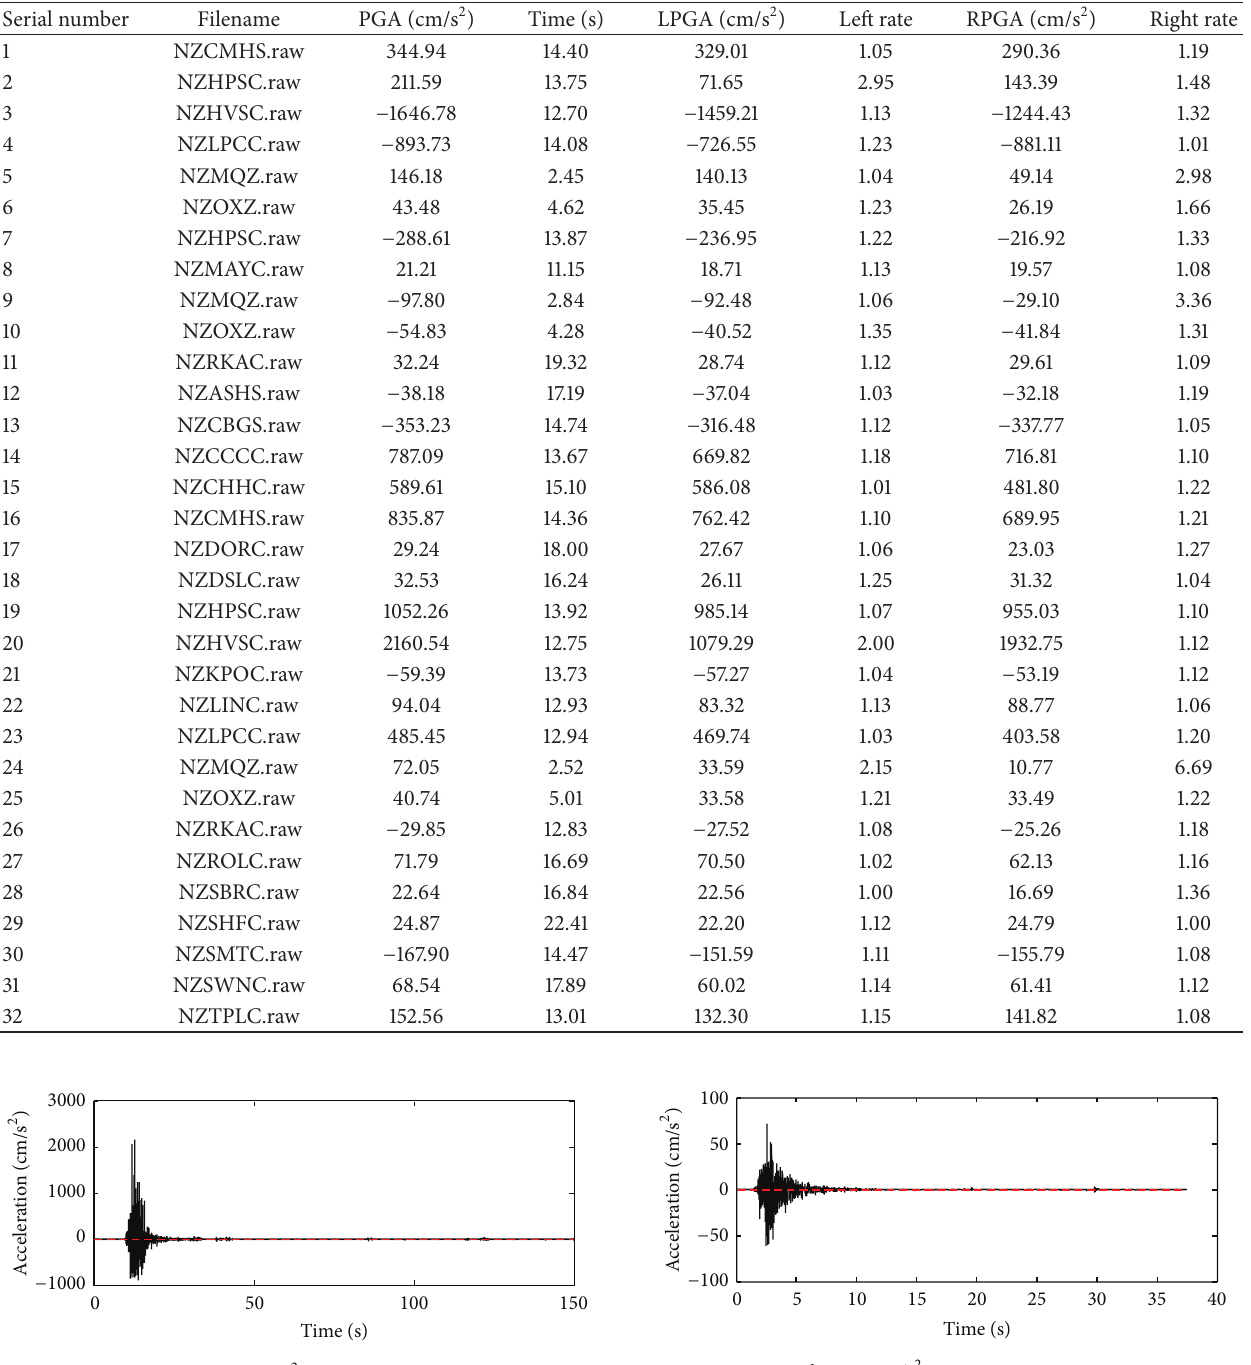
Table 3: Records with ratio of PGA to adjacent points greater than 1.1 in New Zealand Mw6.3 earthquake.